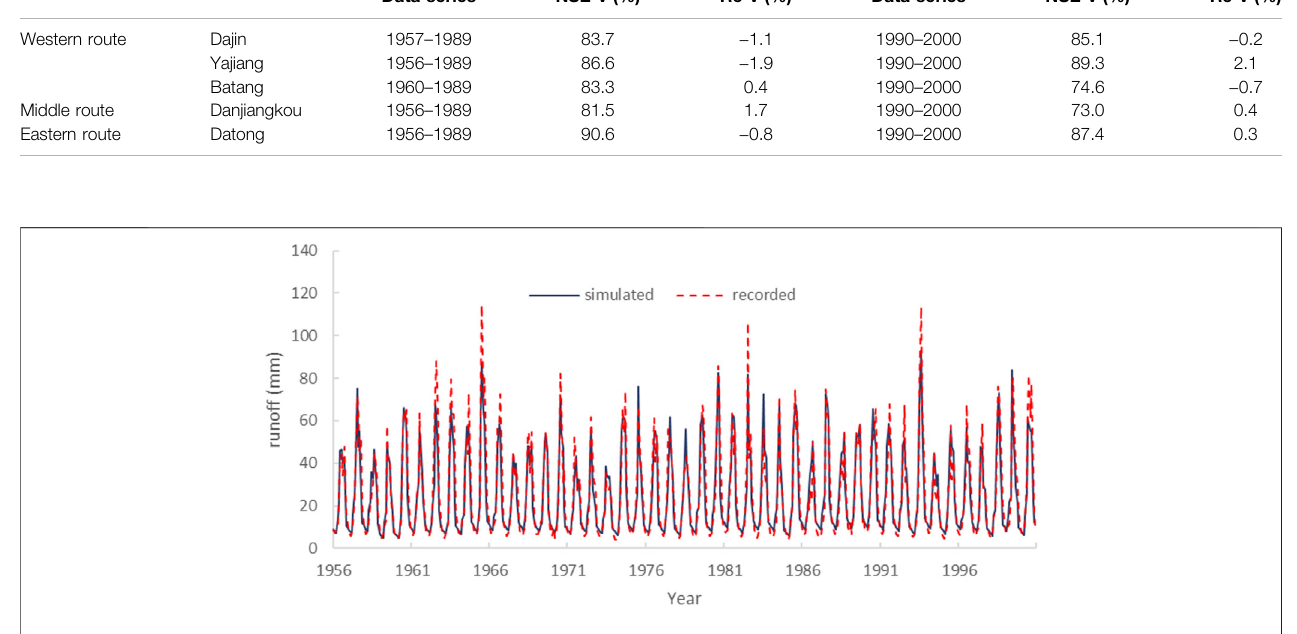
FIGURE 5 | Monthly recorded and simulated runoff at the Yajiang station during 1956 –